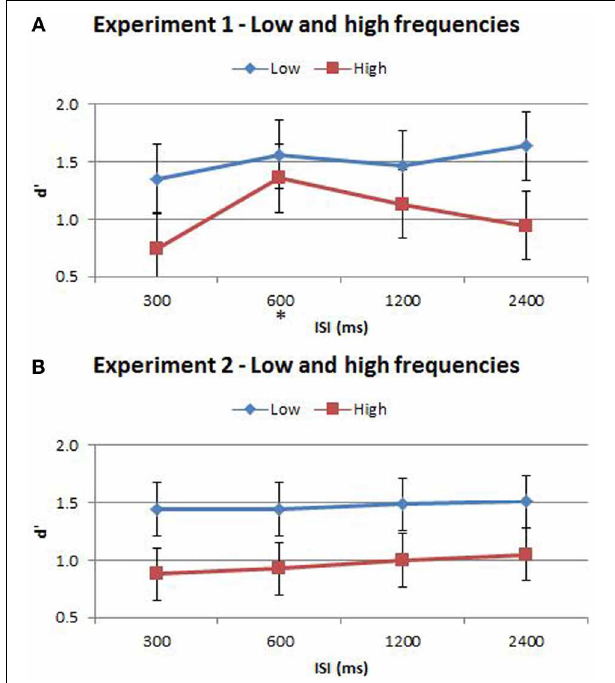
FIGURE 6 | (A) Accuracy comparison between low and high frequencies in Experiment 1. (B) Accuracy comparison between low and high frequencies in Experiment 2. Vibration pairs below the global mean were classified as “low” whilst those greater than the global mean were classified as “high” frequencies. Accuracy was determined by d (cid:2) , which served to reduce the effect of potential response bias. The ISI trial-types for low and high frequencies are indicated below each bar. This analysis excluded trial pairs that contained either the maximum and minimum frequencies in the stimulus-set for each participant as these may be too discrete and or beyond the flutter range of vibrations. The star on the y-axis indicates that Experiment 1 participants were only presented with an ISI of 600ms during the titration procedure. Vertical bars represent within-subject SEM for the frequency factor. Statistical analysis results are displayed below in Table 4 .